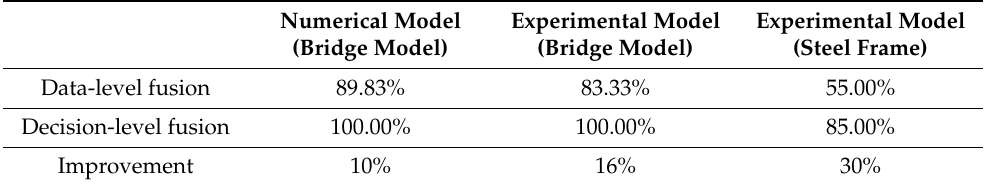
Table 7. Comparisons of the accuracy with the control experiment (data-level fusion).